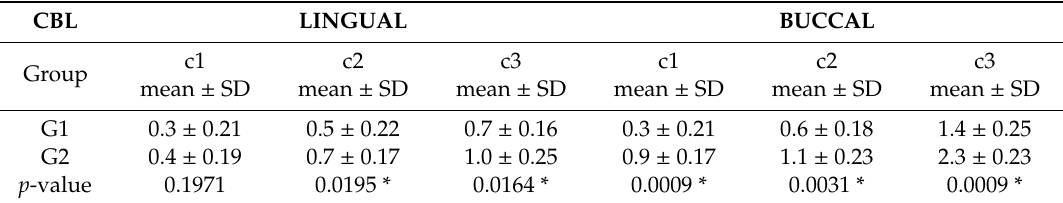
Table 3. Height from implant shoulder to first point of bone-implant contact (CBL): Mean, standard deviation and data comparison ( t -test). * Statistically significant di ff erence ( p < 0.05).